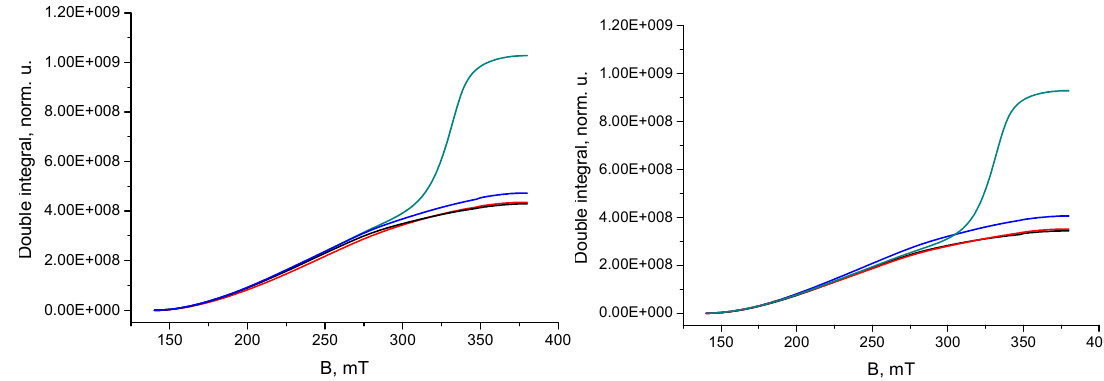
Figure 3. Double integrals for the four samples in two independent experimental series. The groups of three lower curves belong to “organic” radicals, that is, NN-polyphenylene, NN-GNR and DPPH, which do not contain an intrinsic paramagnetic metal ion. The curve with an extra step corresponds to Cu(acac) 2 . The slightly higher curve for the “organic” group corresponds to NN-GNR in the left panel and NN-polyphenylene in the right panel. The step size for Cu(acac) 2 is about equal to the total signal from the background.